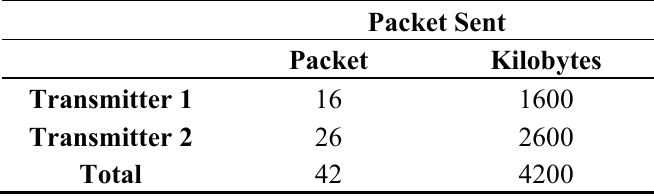
Table 6. Transmission and mobility tests with two transmitters (868 MHz, 0 dBi).